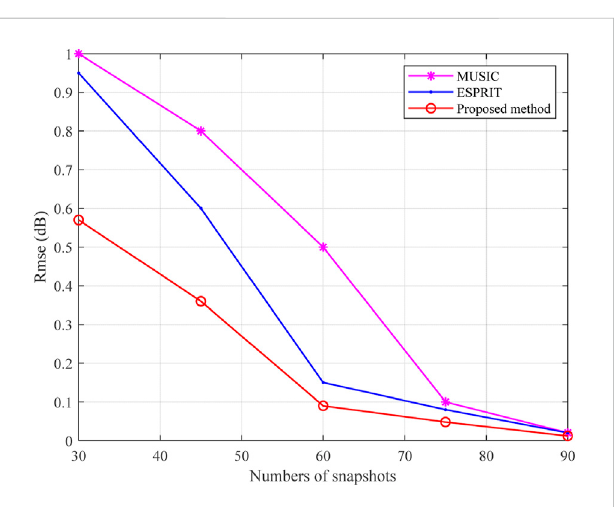
FIGURE 3 DOA estimation performance with different SNR.